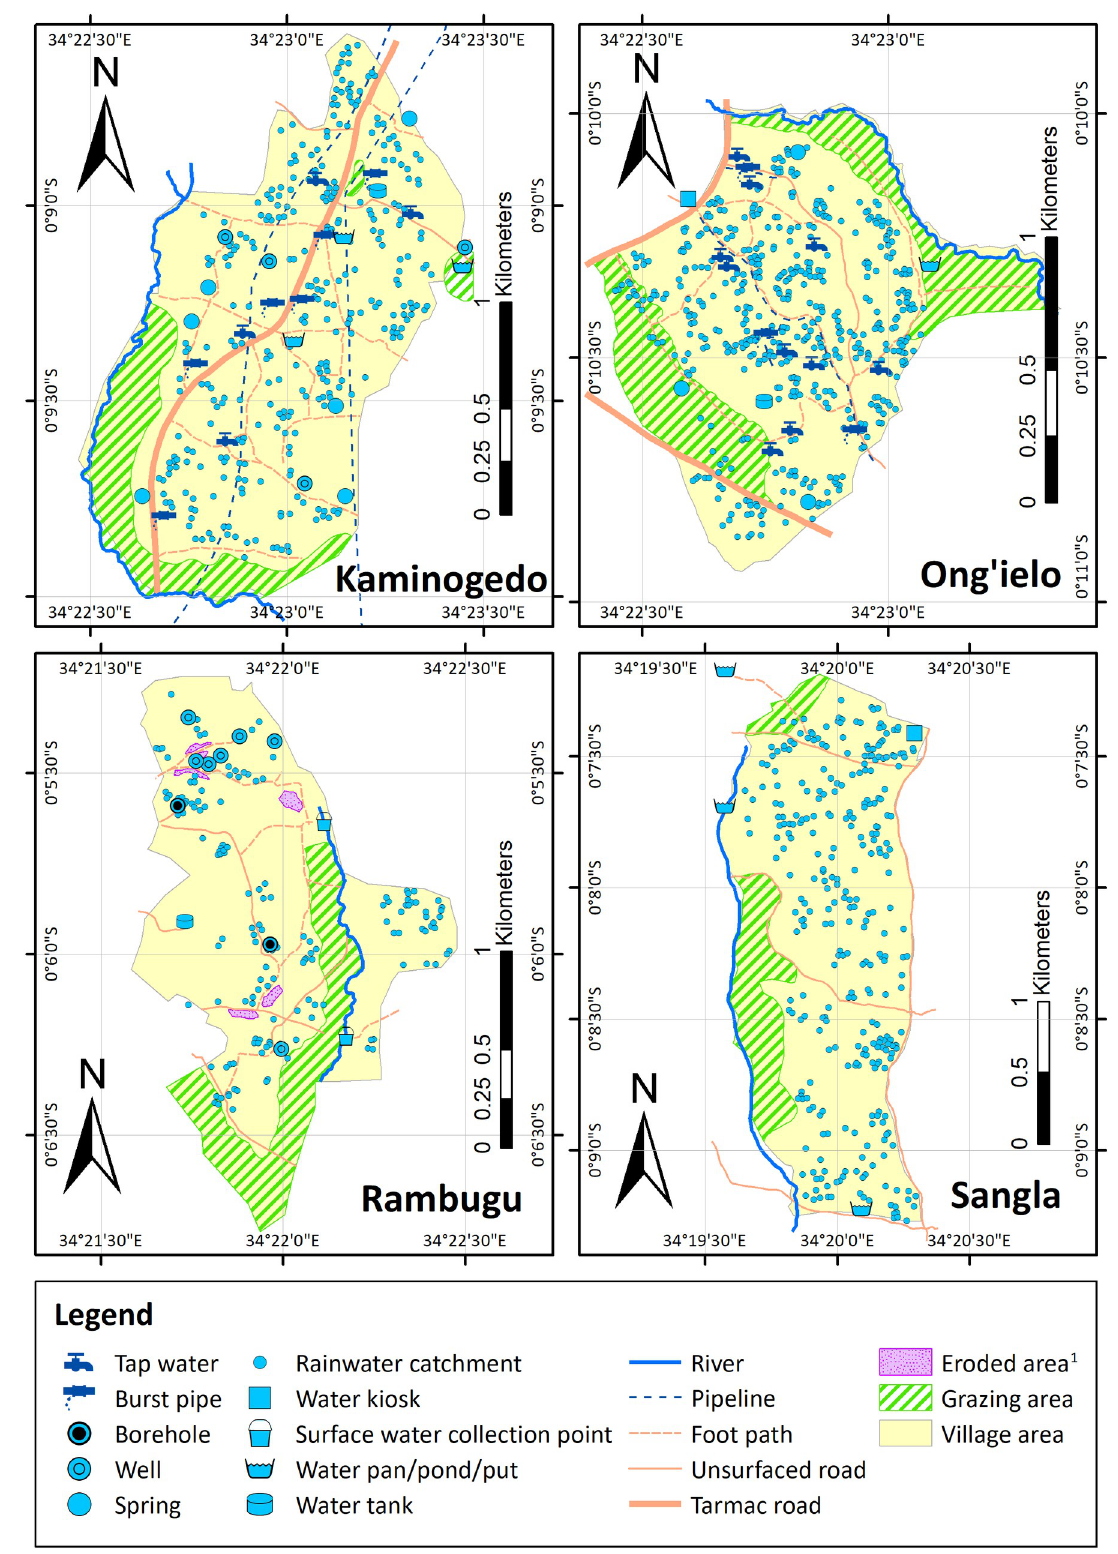
Fig 1. Water sources and contamination hazards mapped by participants in four of the ten villages, overlaid on pipeline data from the local utility for Kaminogedo village. ( 1 Eroded areas as mapped by workshop participants). https://doi.org/10.1371/journal.pone.0255286.g001 PLOS ONE | https://doi.org/10.1371/journal.pone.0255286 July 28,